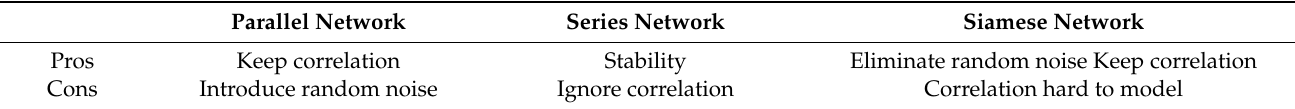
Table 1. Pros and cons of Siamese